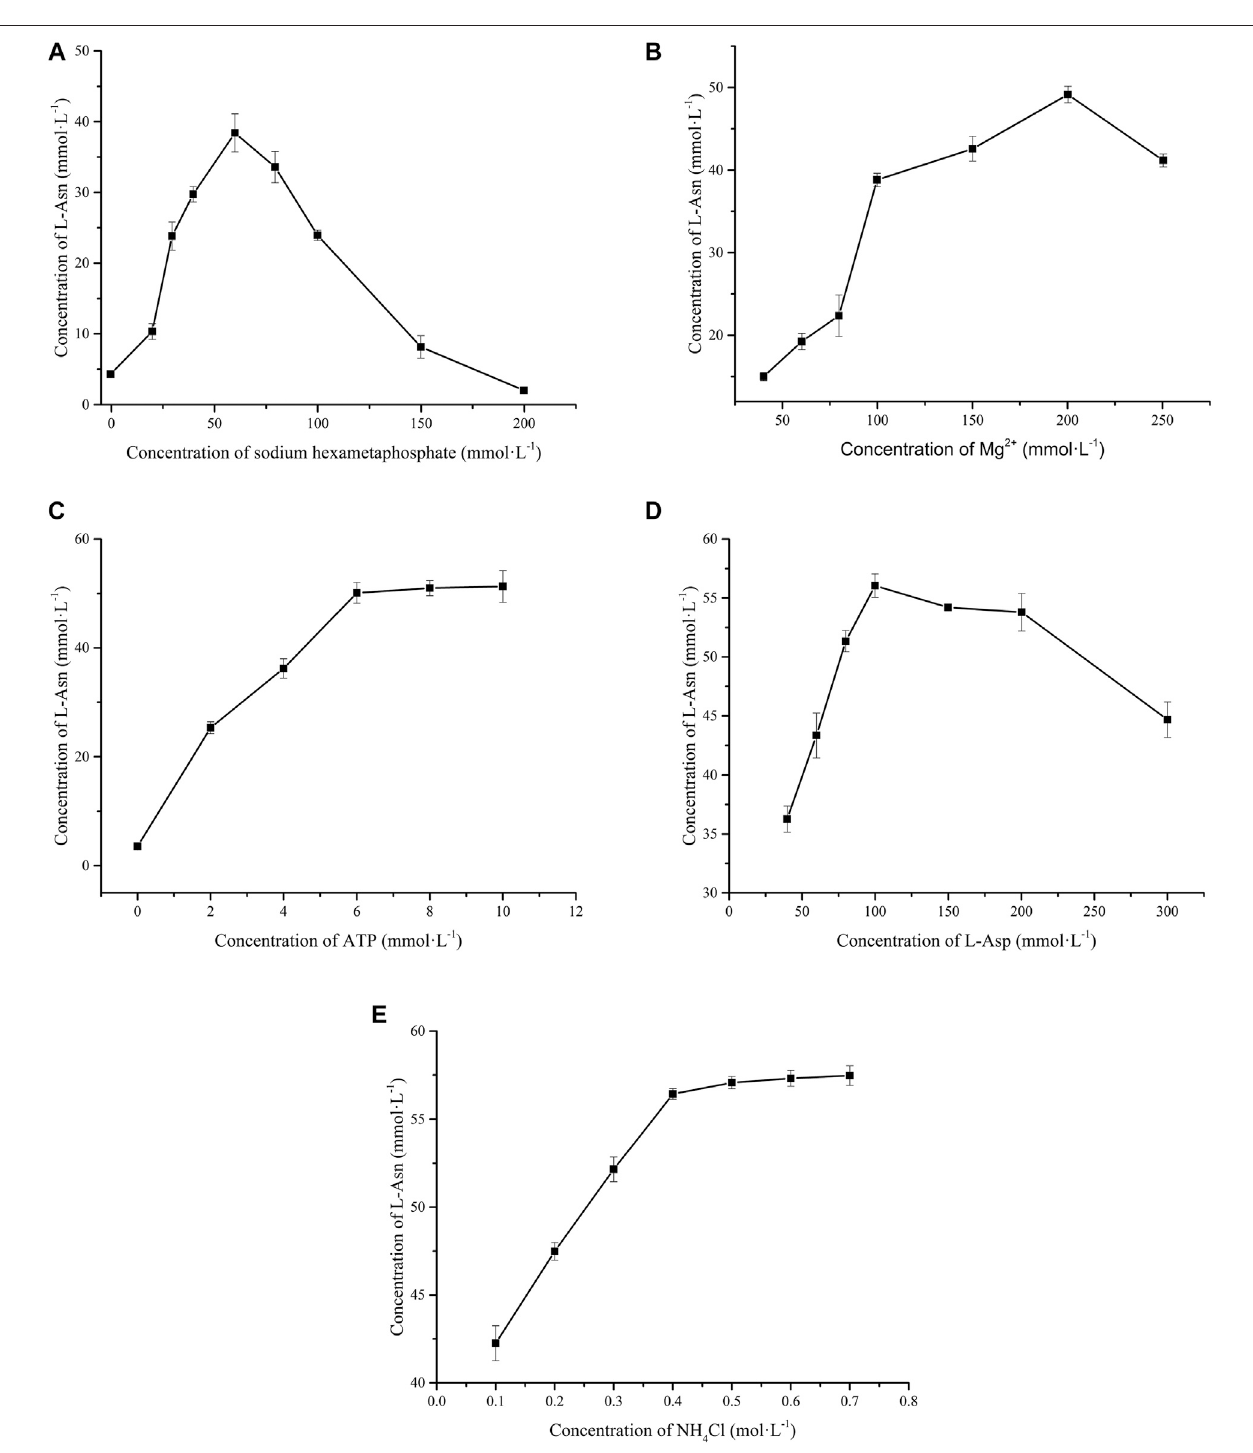
FIGURE 3 | Effects of substrates and co-factor on whole cell catalytic preparation of L-Asn. (A) Sodium hexametaphosphate. (B) Mg 2+ . (C) ATP. (D) L-Asp. (E) NH 4+ .